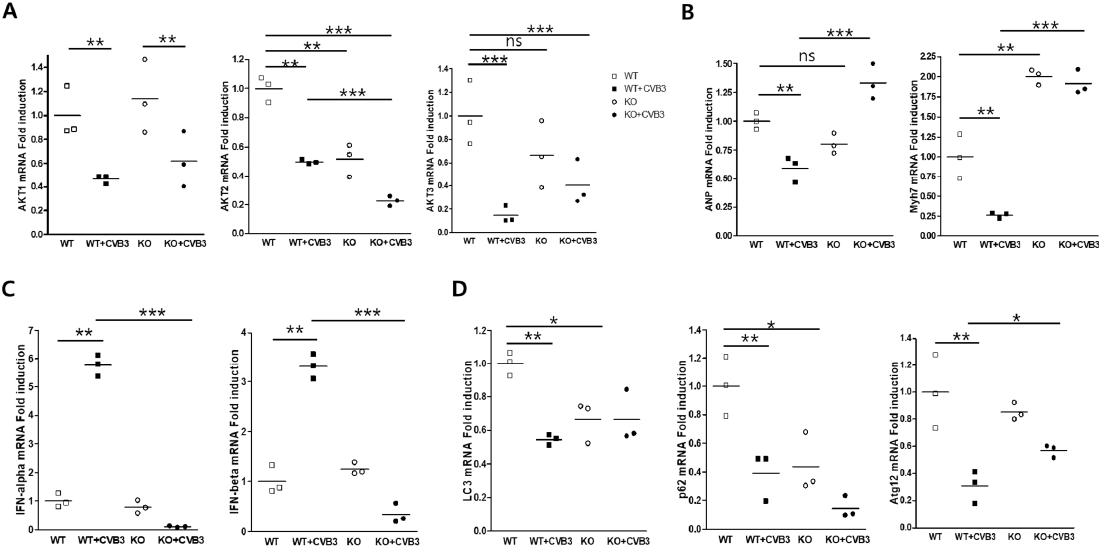
Figure 7. AKT2 deletion attenuated Type 1 interferon transcription during CVB3 infection. Isolated adult myocytes were infected with CVB3, and total RNA was extracted from WT and KO ventricular cardiac myocytes. RNA was subjected to real-time PCR using gene primers relating to inflammatory cytokines, heart damage, and autophagy formation. ( A ) AKT isoform expression was observed in AKT2 KO cardiac myocytes. ( B ) Cardiac myocyte damage was indicated by early gene (ANP and MyH7) induction. ( C , D ) Expression of Type 1 interferon and autophagosome formation genes. Expression of IFN- α , - β , and p62 was not induced by CVB3 infection in cardiac myocytes under AKT2 deletion. All data are the means ± s.e.m. from independent experiments. * p < 0.05, ** p < 0.01 and *** p < 0.001 according to a two-tailed Student’s t